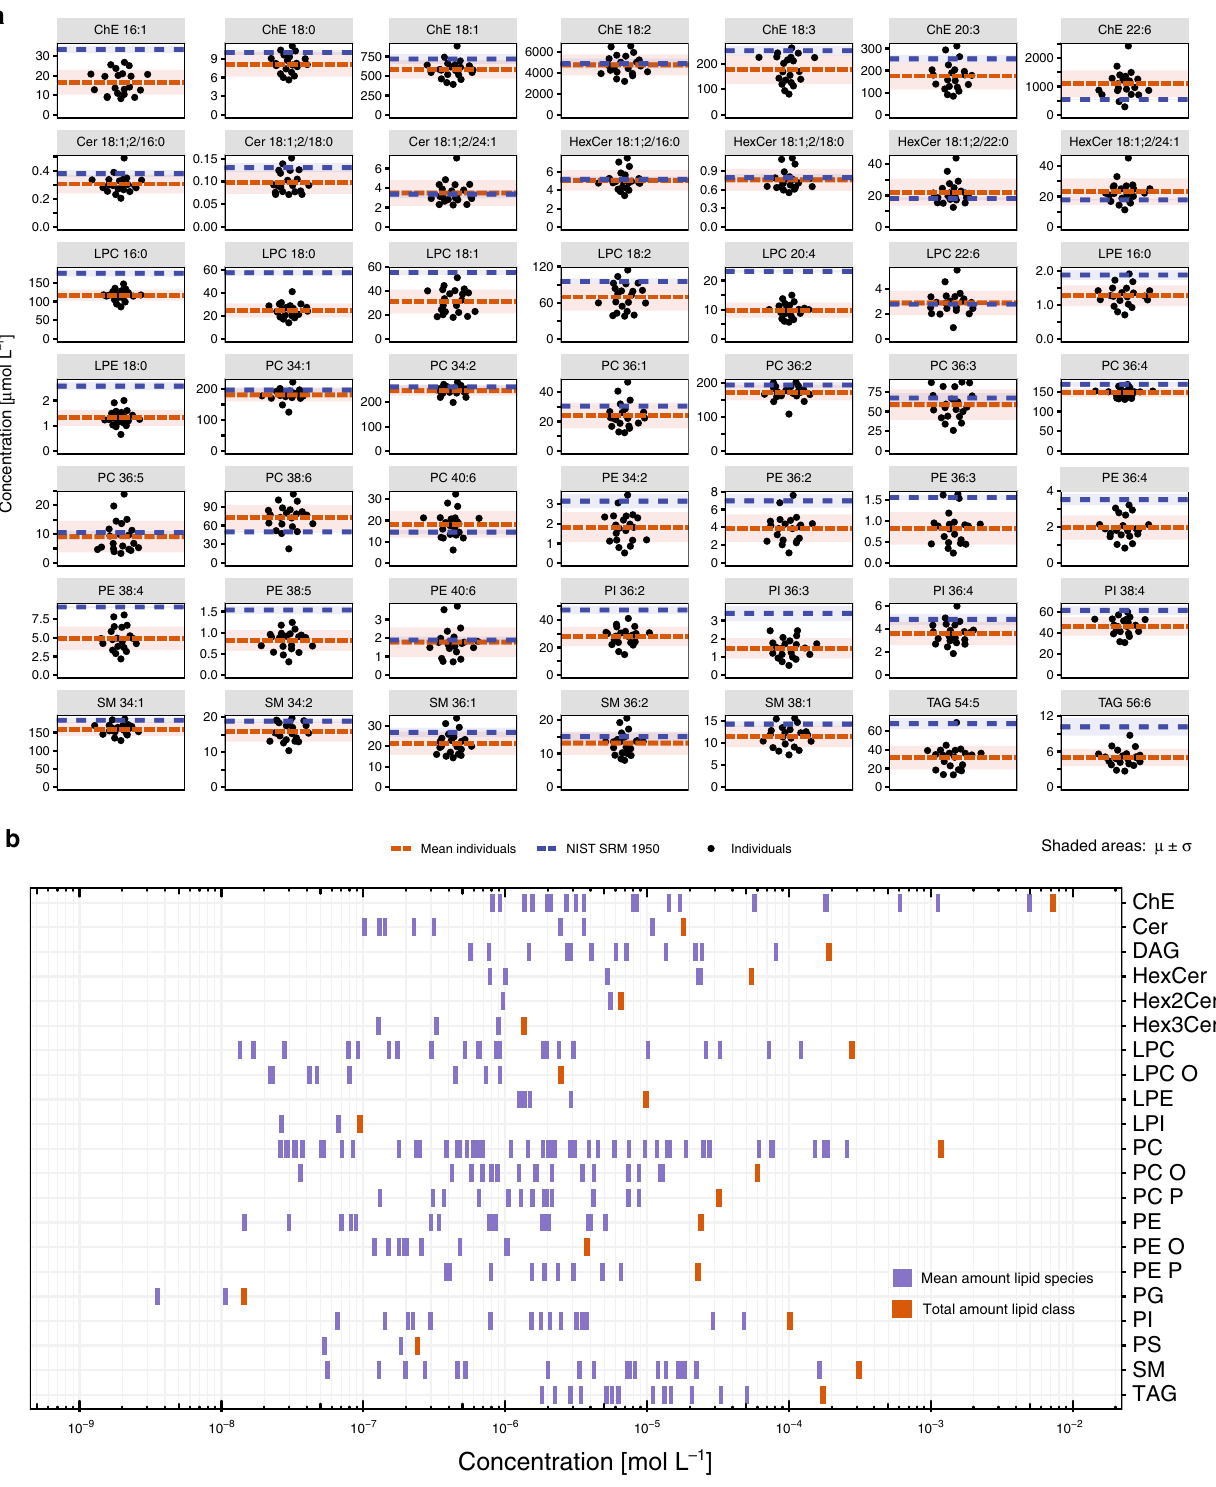
Fig. 6 Quantitative comparisons in the human plasma lipidome con fi rms LipidCreator output. Lipid molecular species from major classes were quanti fi ed from the plasma samples of 21 healthy individuals ( n = 21), and the NIST SRM 1950 reference material, by using transitions generated by LipidCreator. a Concentration differences of selected lipid species between healthy individuals (black dots) and average NIST 1950 plasma samples analyzed in this study (blue line). Each sample was measured with four independent technical replicates. 276 lipid species passed QC fi lters with a linear response R 2 > 0.8 and CV < 20%. Shaded areas represent standard deviation around the mean of the individuals and the mean of the NIST 1950 plasma samples. b The plasma lipid species concentrations across 22 lipid classes are displayed as blue bars. The sum of the concentrations of individual lipid species of the lipid classes are indicated as vertical thick red bars (right). Source data are provided as a Source Data fi